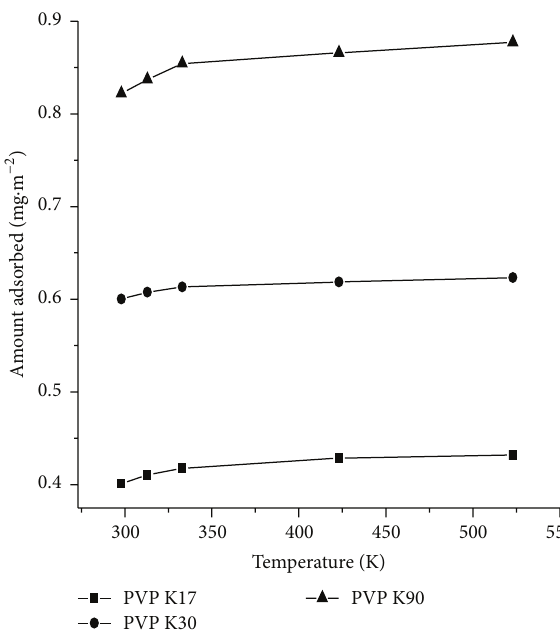
Figure 10: Effect of pretreatment of AEROSIL OX 50 on the adsorption of PVP. The error percentage was about